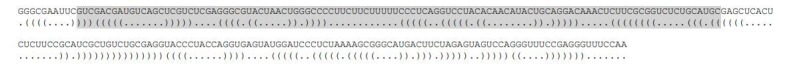
Optimal secondary structure prediction for 3e5